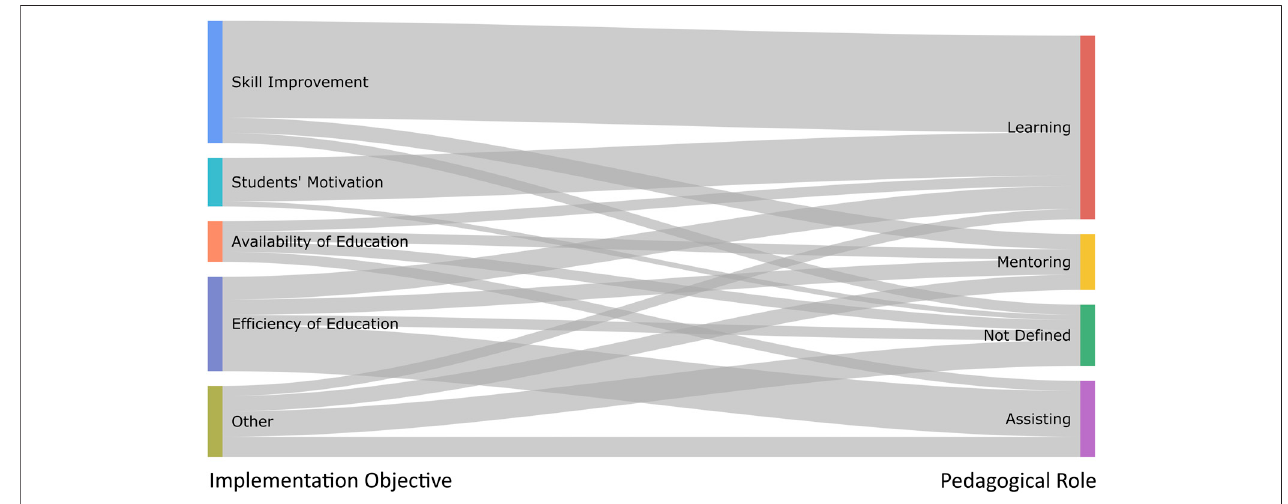
FIGURE 9 | Relations graph of pedagogical roles and objectives for implementing chatbots.